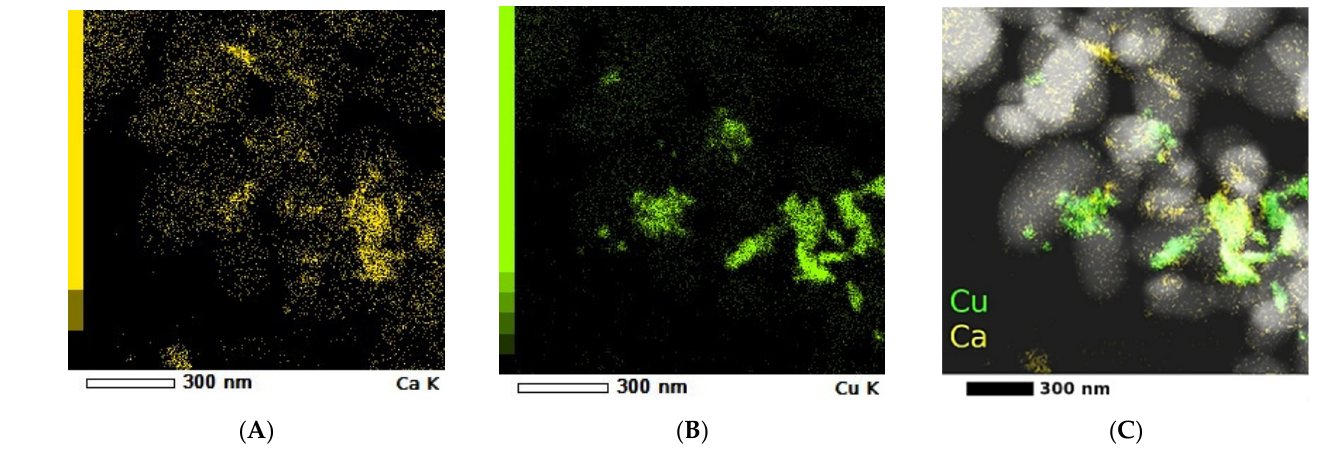
Figure 3. STEM dark-field images for sample S2: ( A ) distribution of Ca; ( B ) distribution of Cu; ( C ) distribution of Ca and Cu.